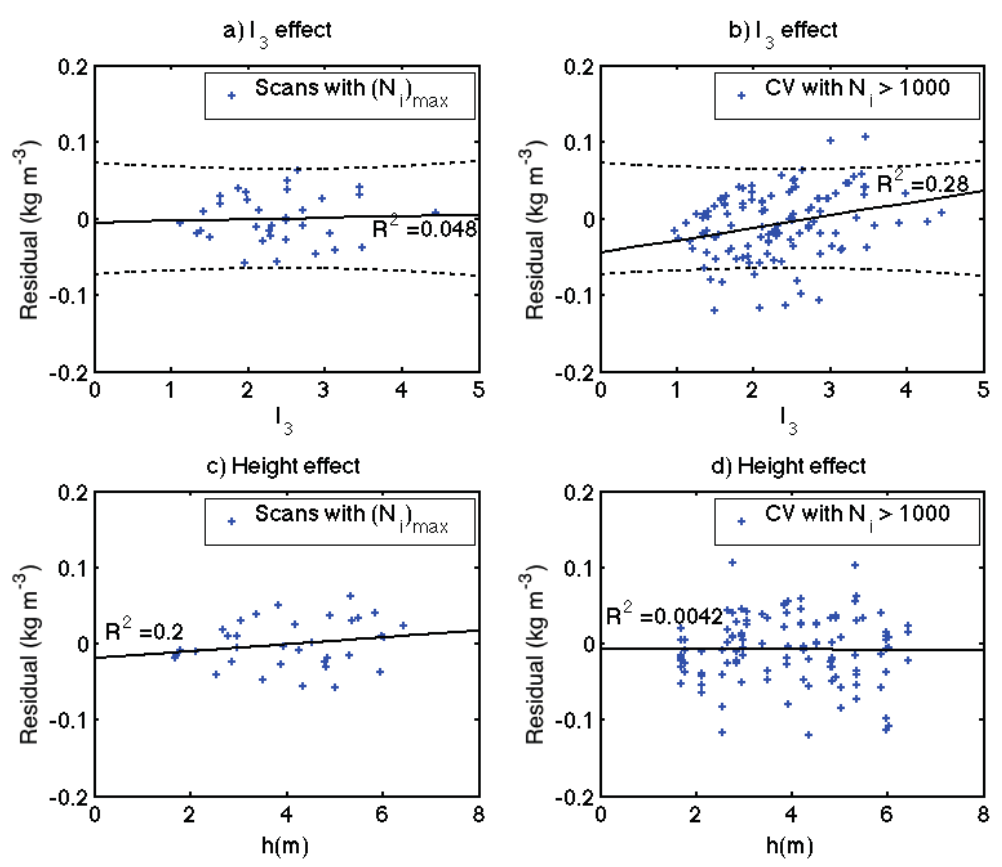
Figure 7. Analysis of residuals of the model based on I 3 and the ( N i ) max : ( a ) function of I 3 on the ( N i ) max data set; ( b ) function of I 3 on the N i > 1000 data set; ( c ) function of calibration volume heights on the ( N i ) max data set; and ( d ) function of calibration volume heights on the N i > 1000 data